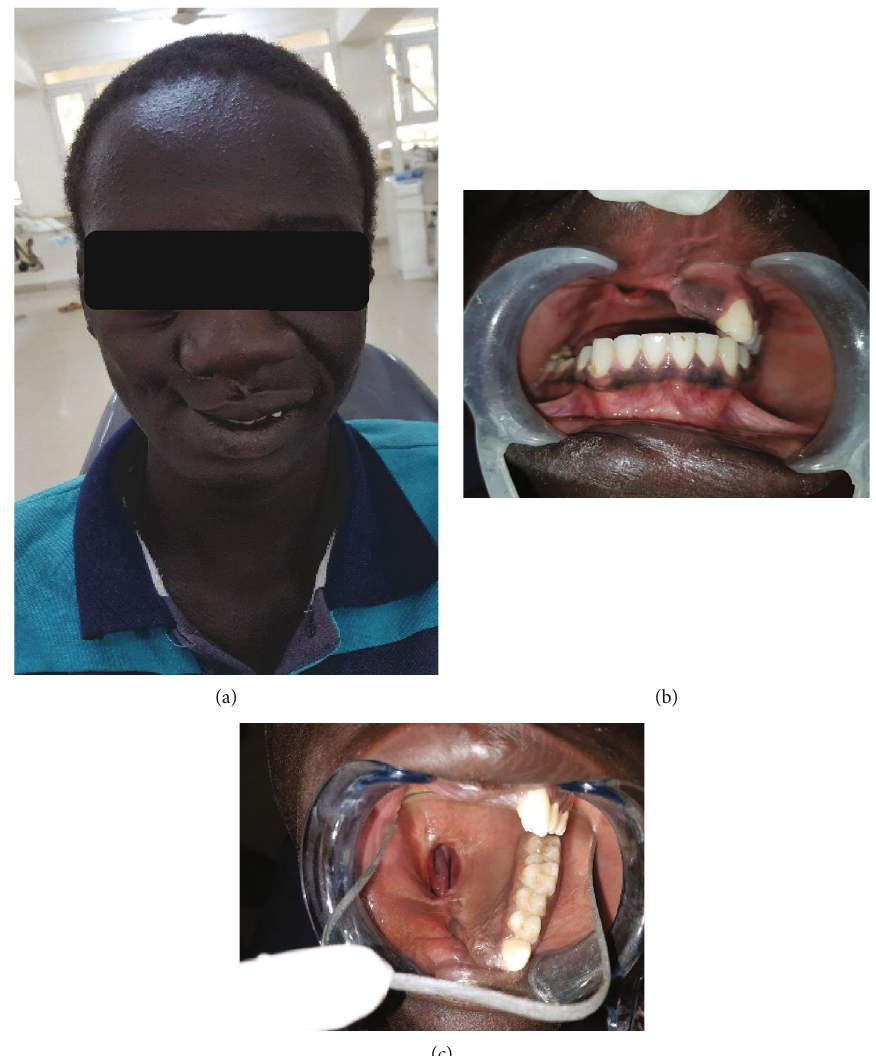
Figure 1: (a) Extra oral view showing facial deformation of the right side; (b) maxillary and mandibular arch occlusion; (c) intraoral view of the maxilla showing